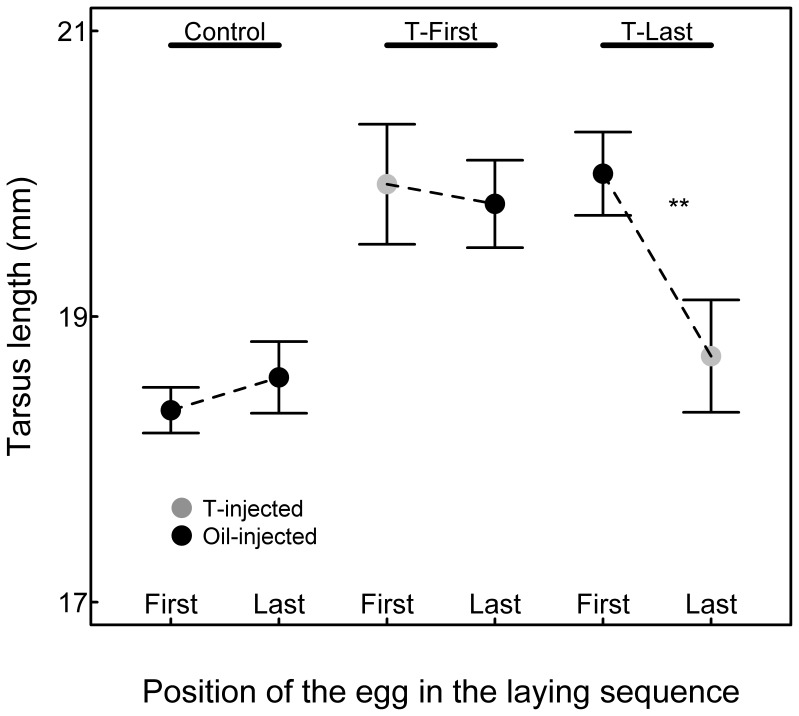
Tarsus length (mean ± SE) of chicks in relation to the laying position and treatments.Grey points indicate chicks hatched from T-injected eggs. Black points indicate chicks hatched from oil-injected eggs.